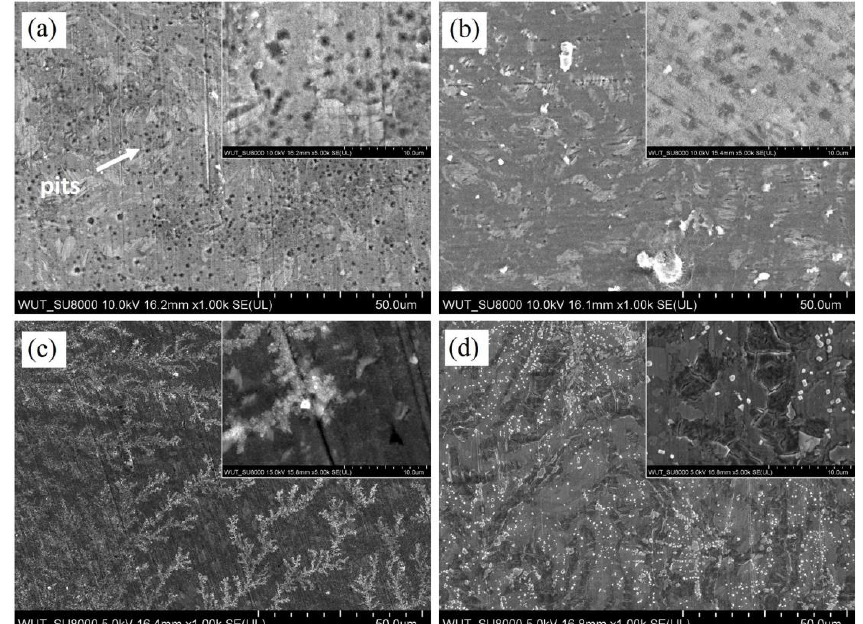
Figure 9. Characterization of the corroded surfaces of WZ42 after corrosion products removal after 1 h of immersion in ( a ) 0.01 M NaCl, ( b ) 0.1 M NaCl, ( c ) 1 M NaCl, and ( d ) PBS.